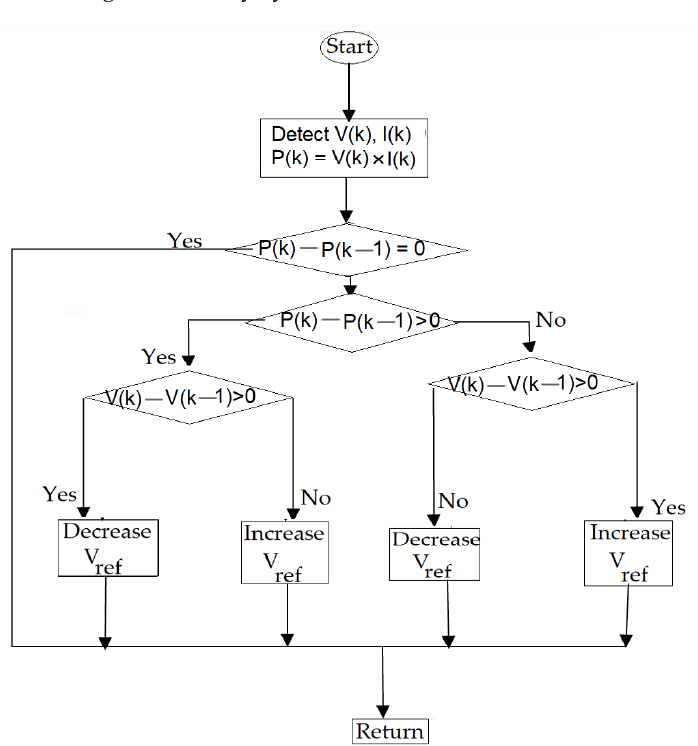
Figure 2. Perturb and observe